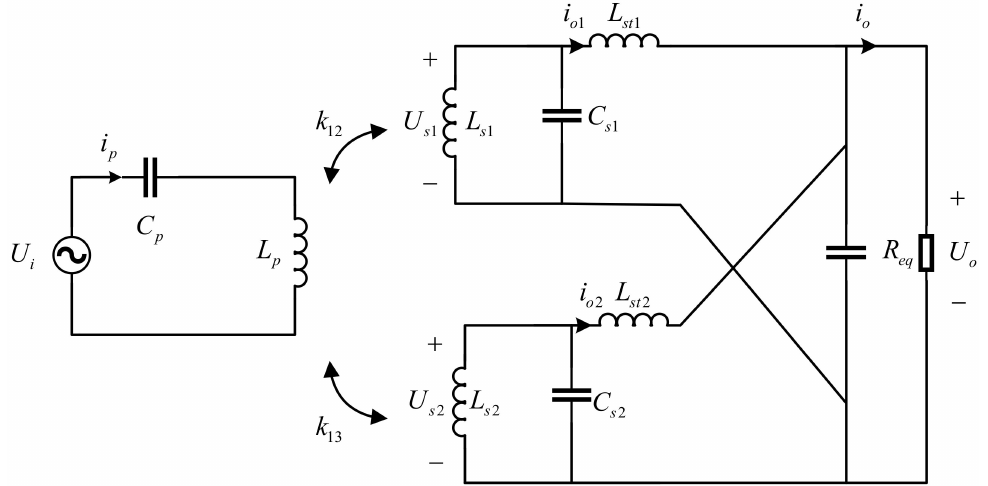
Figure 24. S-LCL AC equivalent